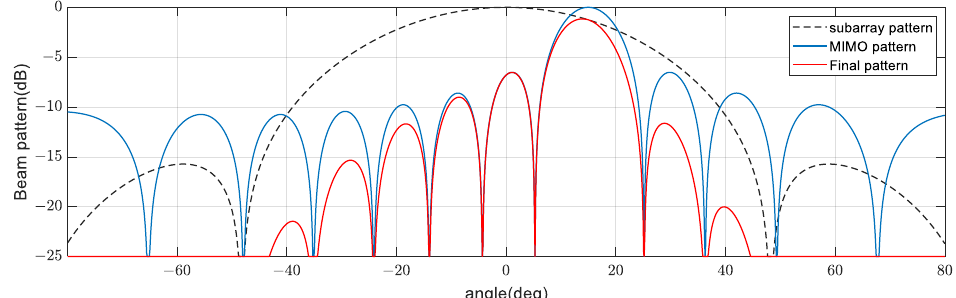
Figure 6. The final beampattern when a Taylor window is applied to subarray beamforming. On the other hand, when the receive array is composed of an analog beamforming subarray without overlap, another consequence appears in addition to the pattern con- straint. Figure 7 shows the receive antenna configured in the form of a subarray. In this